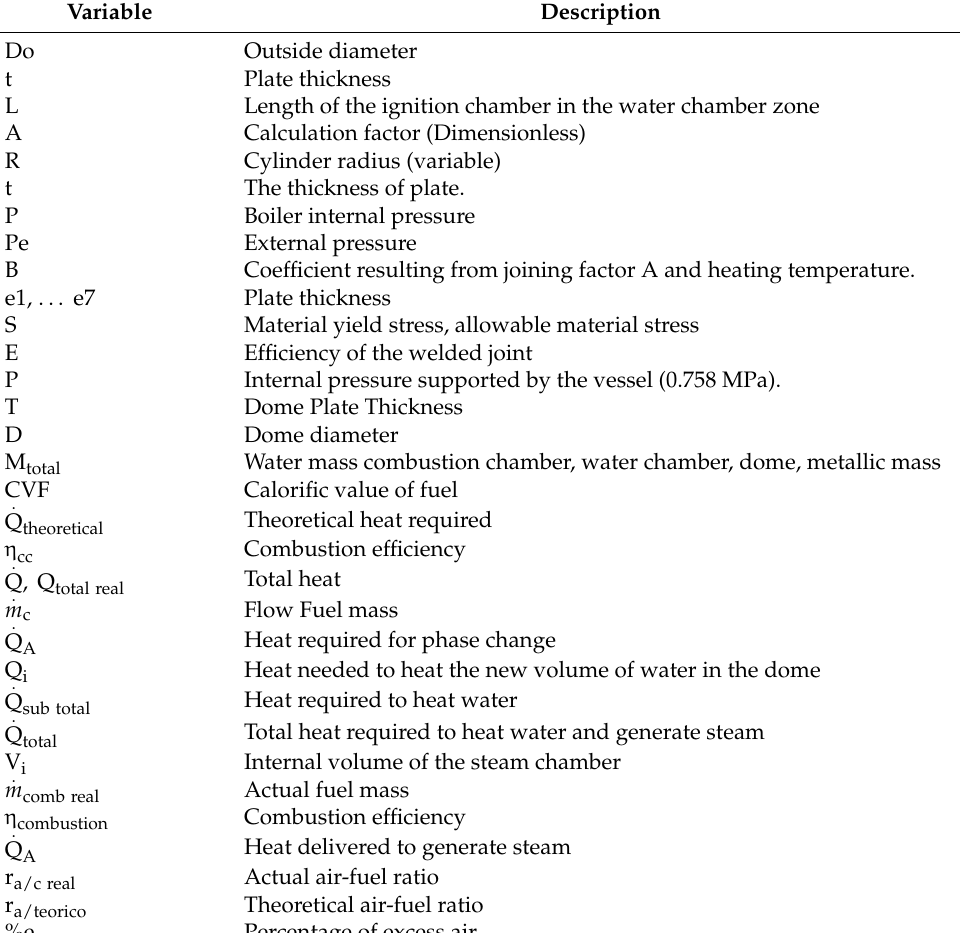
Table 3. Description of the variables used in the